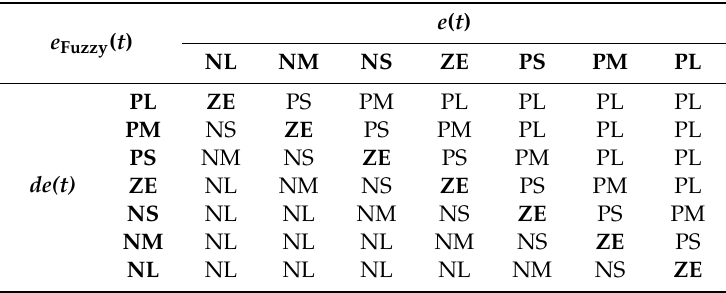
Table 1. The fuzzy rule